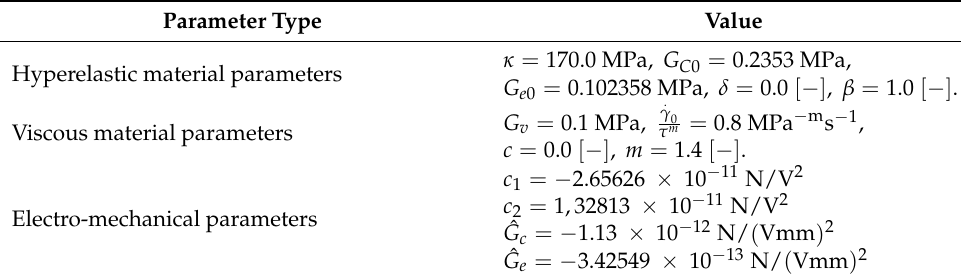
Table 1. Material